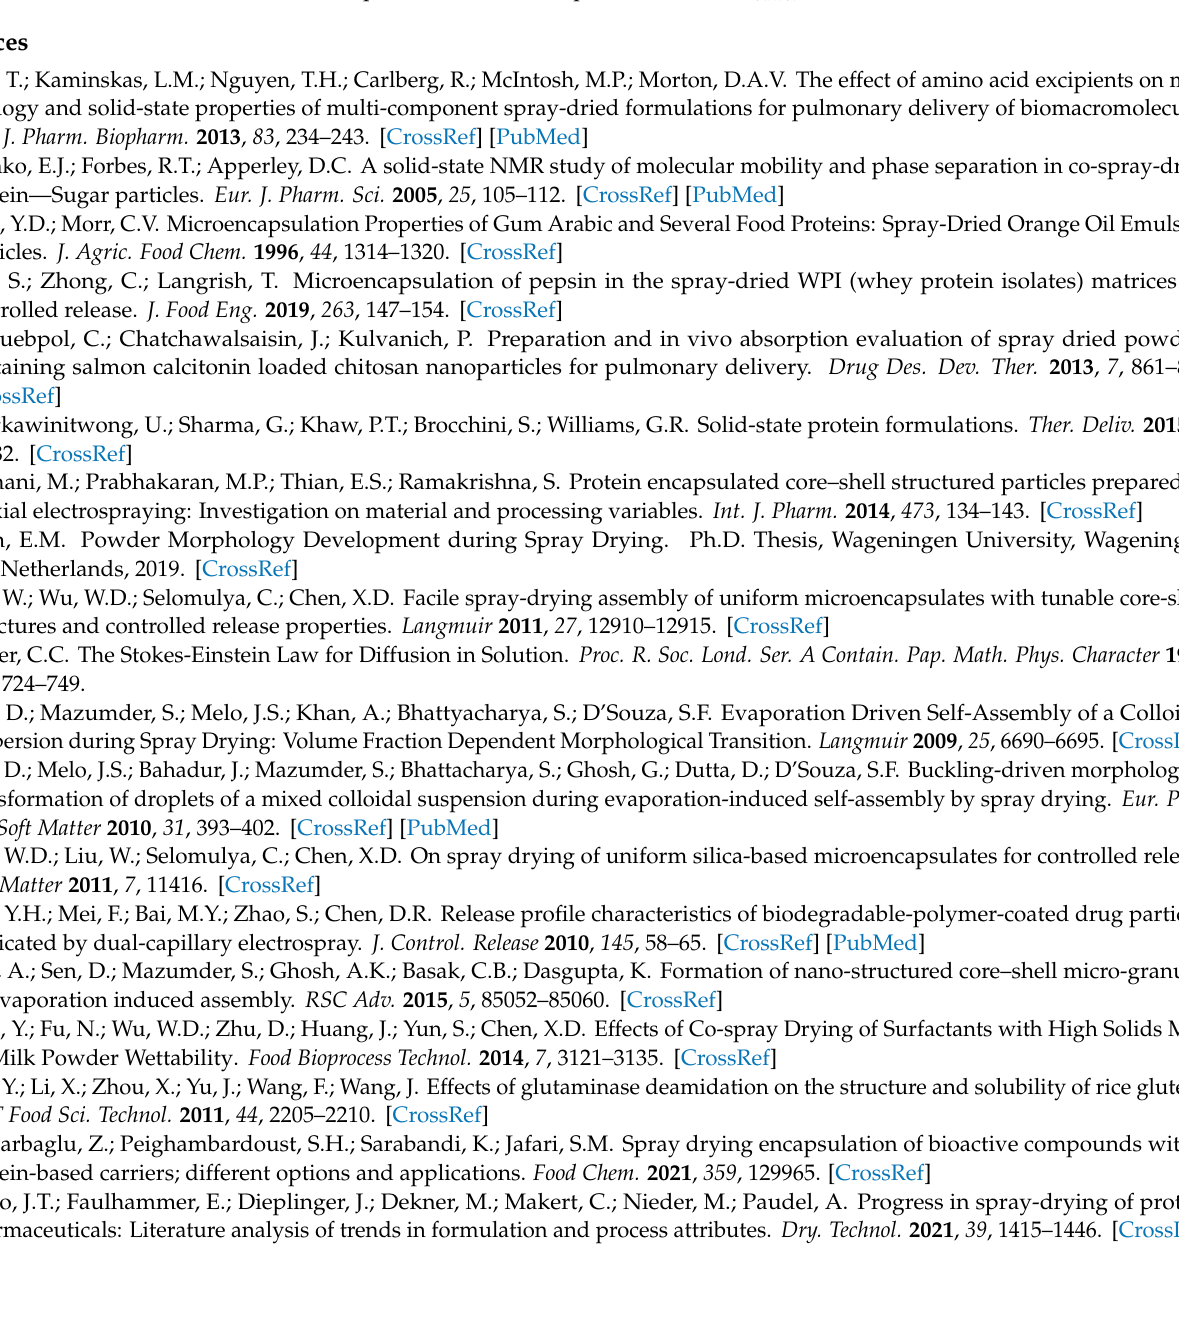
Figure A11. Relationship between the absolute value of zeta potential ( ζ ) and excipient preferential surface adsorption at ( a ) room temperature and ( b ) T outlet (70